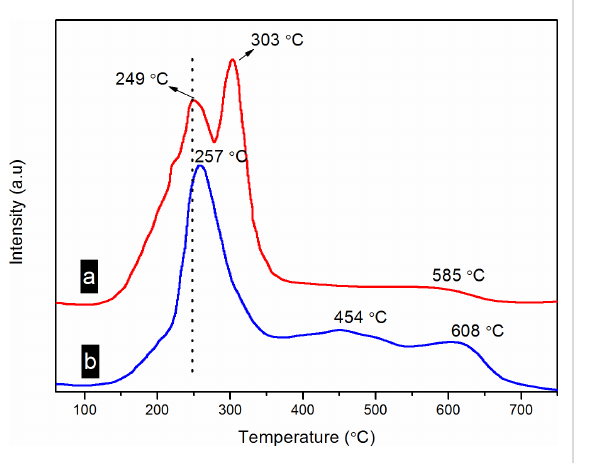
Figure 6: H 2 - TPR curves of two catalysts: (a) 4% MnO 2 –CuO–Fe 2 O 3 / CNTs and (b) Mn–Cu–FeO x /CNTs - IWIM.